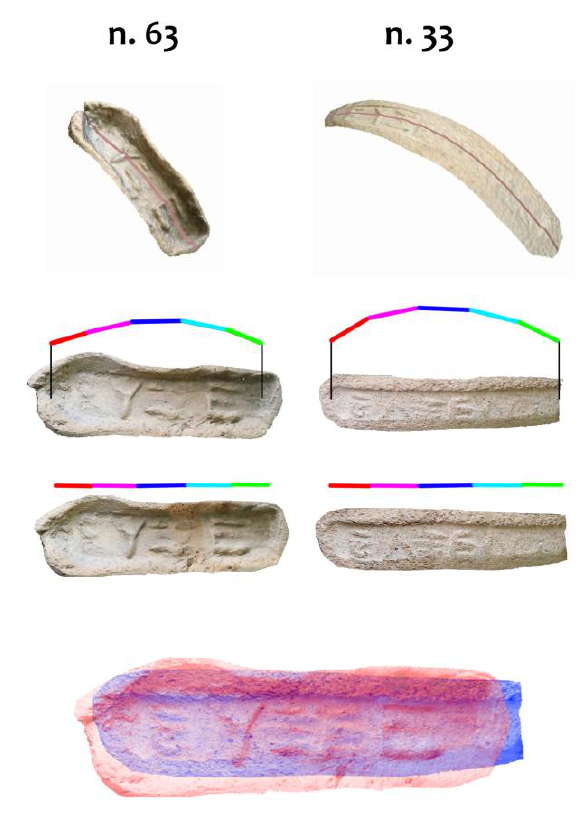
Figure 9 : Comparison between stamps No. 63 and No. 33: they are of the same type but derive from different punches.